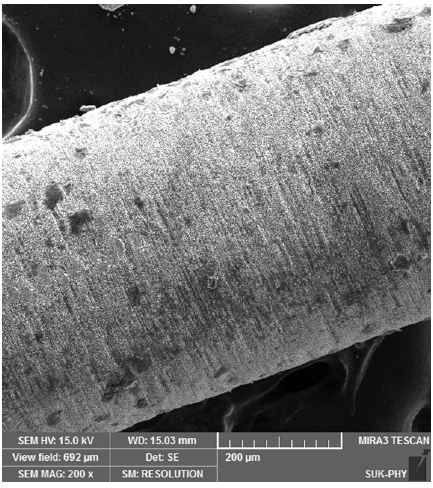
Figure 2: Photograph of electrode